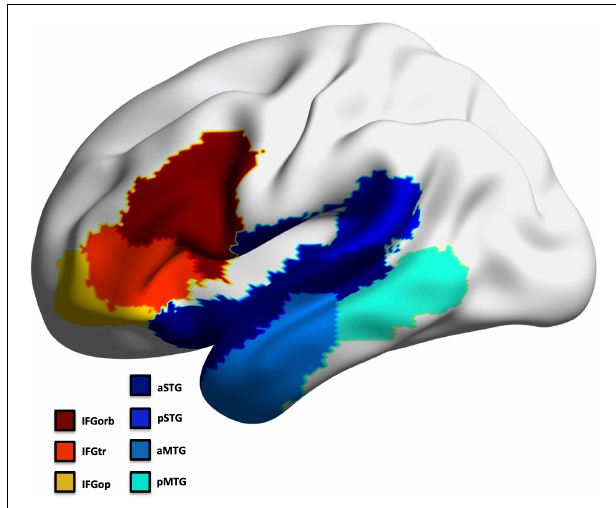
FIGURE 2 | Left hemisphere language ROIs.